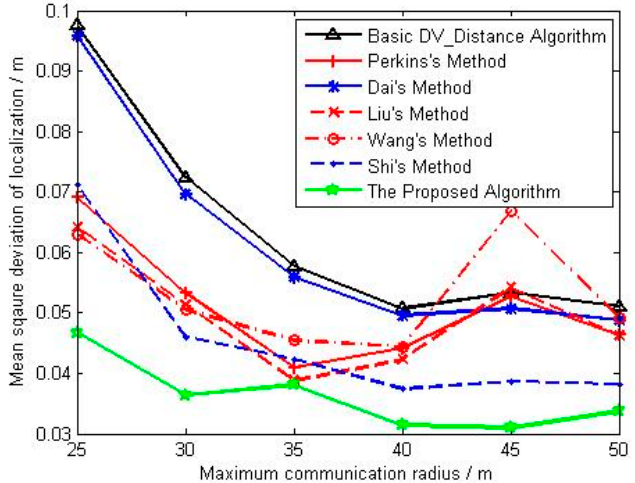
Figure 10. The change curve of mean square deviation with maximum communication radius.